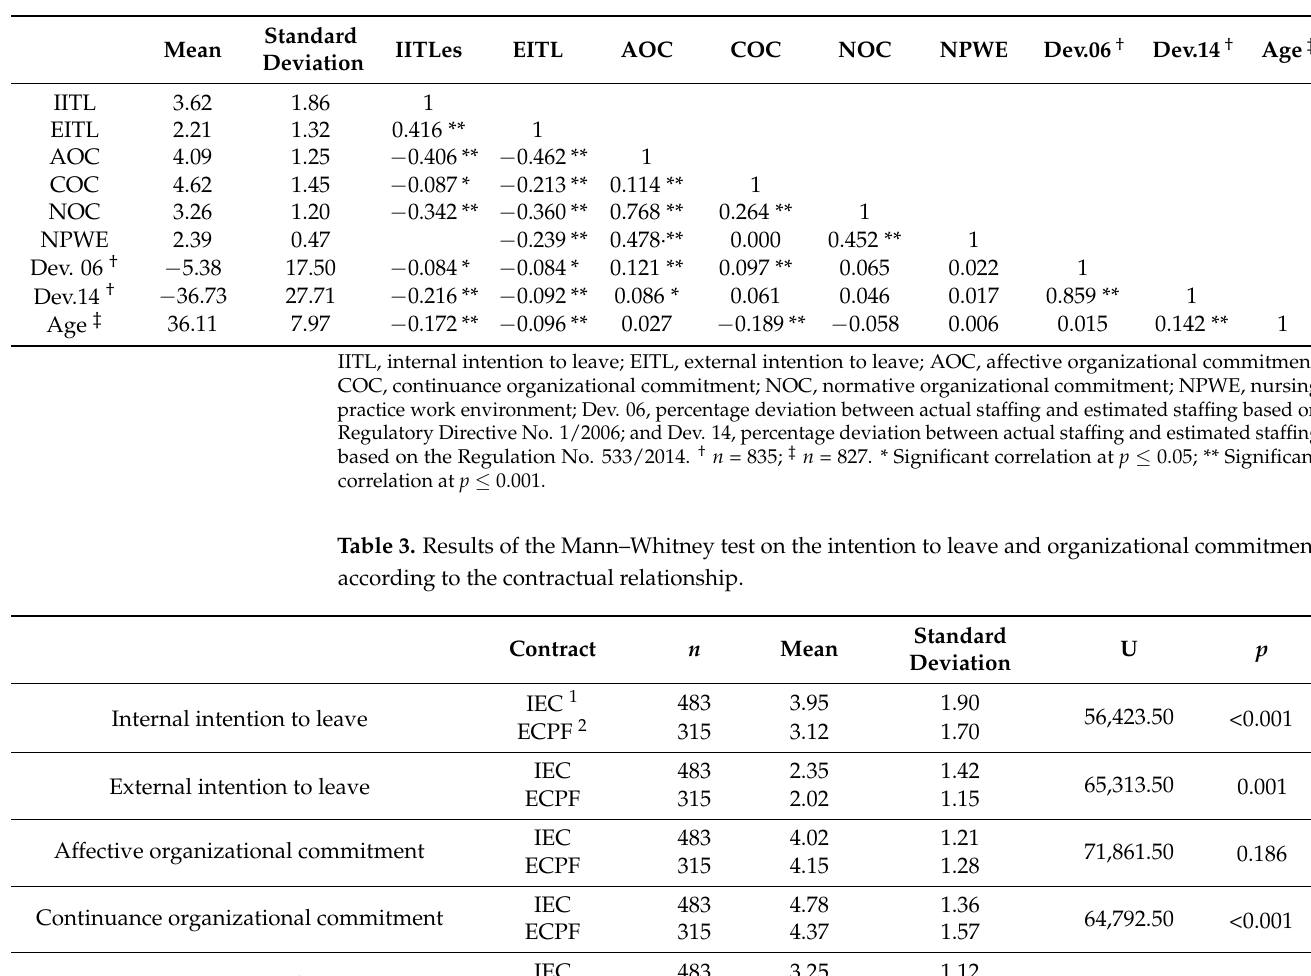
Table 2. Descriptive and correlational analysis of nurses’ intention to leave, organizational commit- ment, work environment, adequacy of staffing, and age ( n = 850).